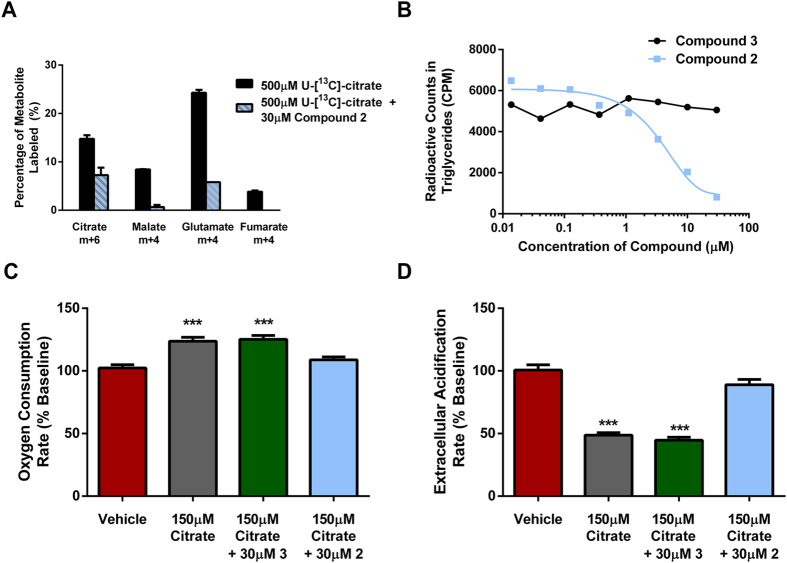
Impact of citrate and compound 2 or 3 on cellular metabolism.(A) U-[13C]-citrate uptake and incorporation into malate, glutamate, and fumarate as a percentage of total cellular concentrations. No label was detected in cells treated with unlabeled citrate (n = 2). (B) Incorporation of [14C]-citric acid into triglycerides in human hepatocytes, treated with either compound 2 or 3 (n = 1). (C,D) Oxygen consumption and extracellular acidification rates in HEKNaCT treated with vehicle, compound 2 or 3 (***P < 0.001; one-way ANOVA - Tukey’s multiple comparison test).